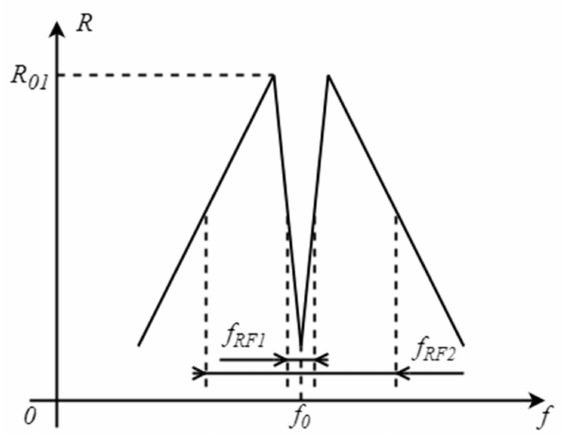
Figure 14. Estimated frequencies based on measured power ratio function: R 01 —Reflection index for the first subrange (adapted from [28]).